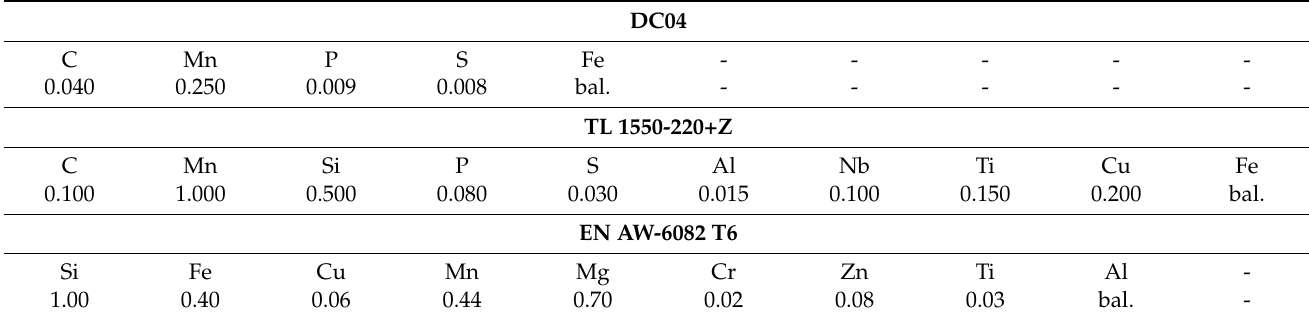
Table 1. Chemical composition of the materials, wt. %.